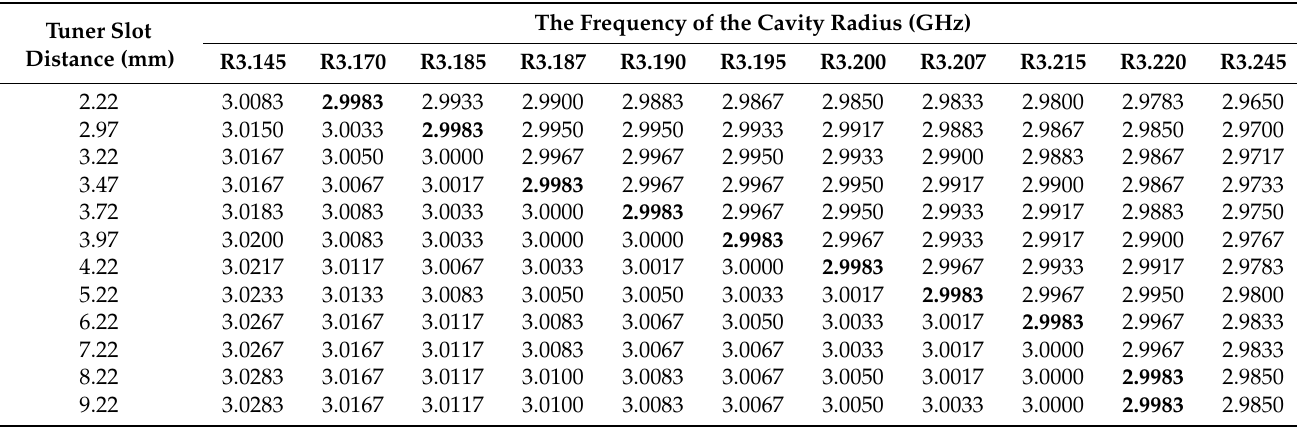
Figure 17. The simulation results of the resonant frequency with the adjustment of the electrical conductivity. Table 5. Simulation results of the resonant frequency by PIC simulation method.